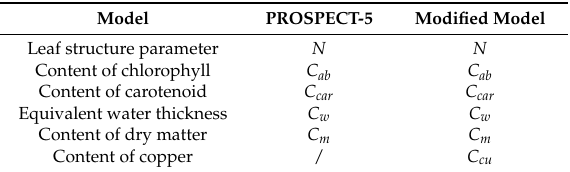
Figure 2. The steps of the method used in this study. Table 1. The input variables of the modified model and the PROSPECT-5 model (for comparison).